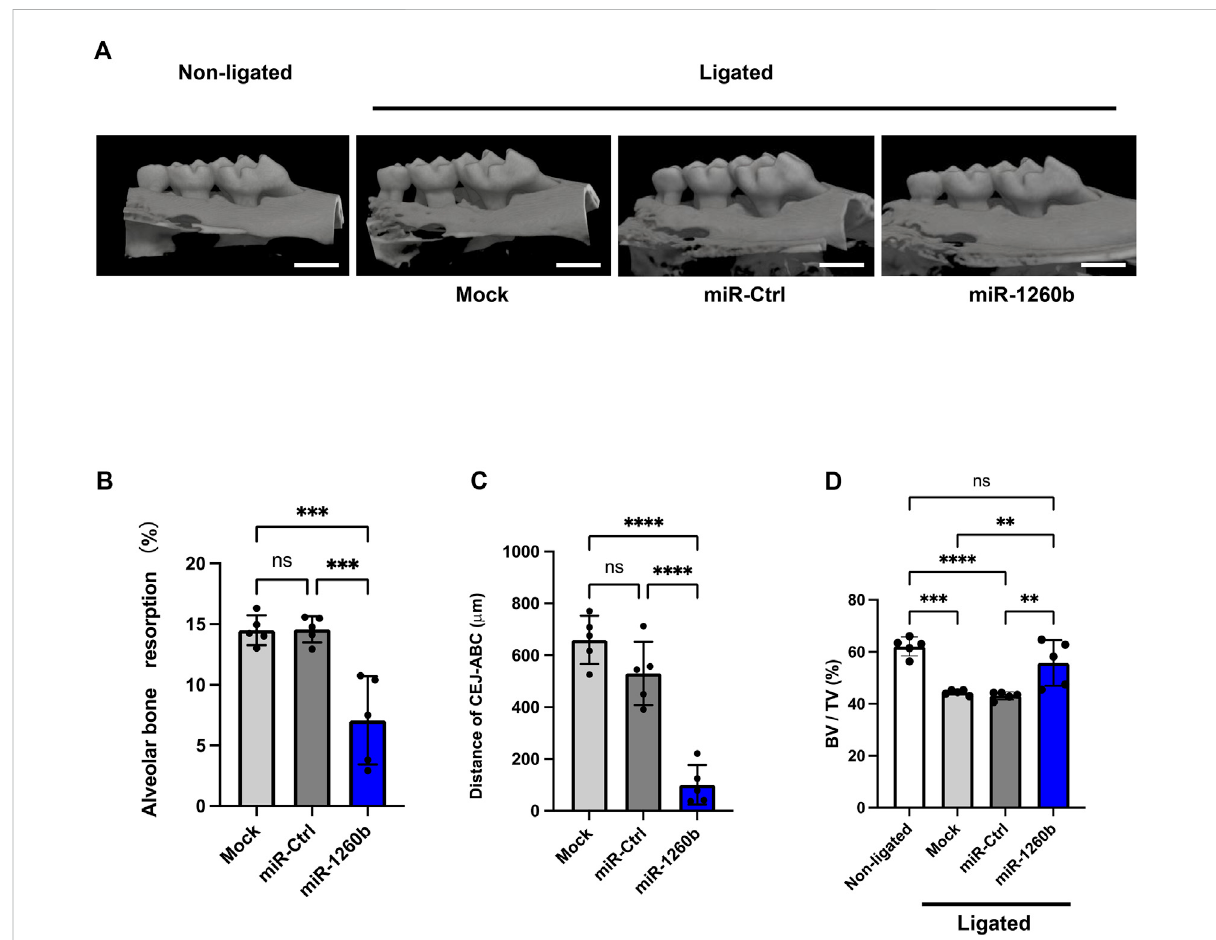
Local injection of miR-1260b inhibits alveolar bone loss in the mice periodontal model. (A) Three-dimensional micro-computed tomography (micro-CT) images of the maxillae in each treatment group on day 7 after ligature placement. Scale bar = 1,000 μ m. (B – D) Periodontal bone resorption analysiswasperformedusingasplit-mouthexperimentaldesign:onesideofthemaxillawasligatedandlocallyinjectedwithmiR-mimic- PEI-NPs, whereas the other side without ligation served as its own control. (B,C) Relative alveolar bone resorption volume (B) and the distance from the cementoenamel junction (CEJ) to the pinnacle of the alveolar bone (AB) (C) were calculated by (non-ligated – ligated) groups. (D) Bone volume/tissue volume (BV/TV). Error bars represent the mean ± SD, n = 6. ns: not signi fi cant, ** p < 0.01, *** p < 0.001, **** p < 0.0001. The signi fi cance of differences between groups was determined using one-way ANOVA, followed by correction for multiple comparisons with Tukey ’ s post hoc